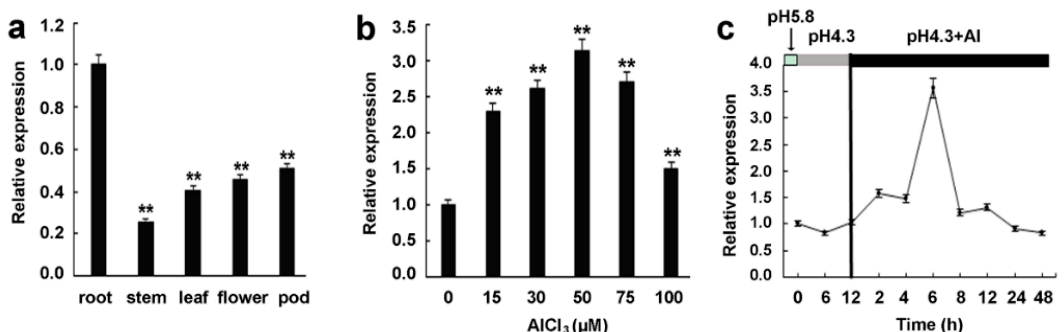
Figure 2. Expression patterns of GsMAS1 in tissues and under acidic aluminum exposure. a .